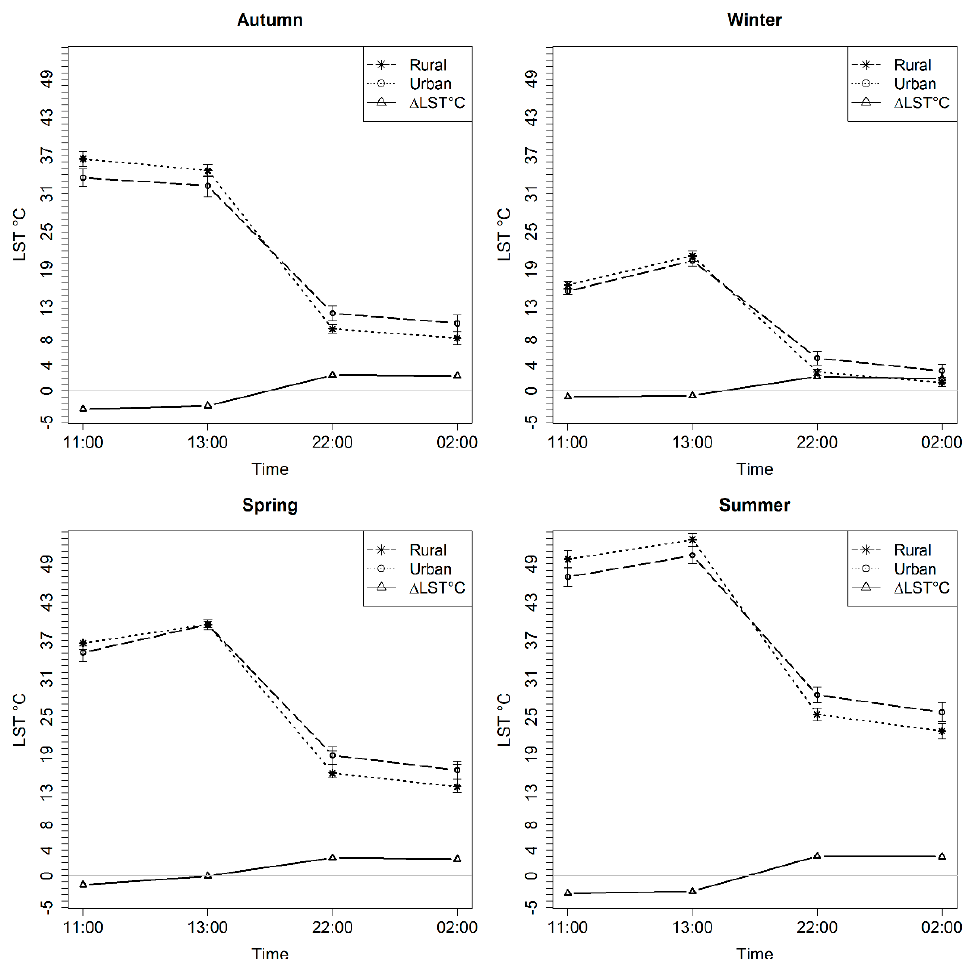
Figure 4. Diurnal variation of average Land Surface Temperature in different seasons over 12 years from Aqua and Terra MODIS and Surface Urban Cool Island/Surface Urban Heat Island.